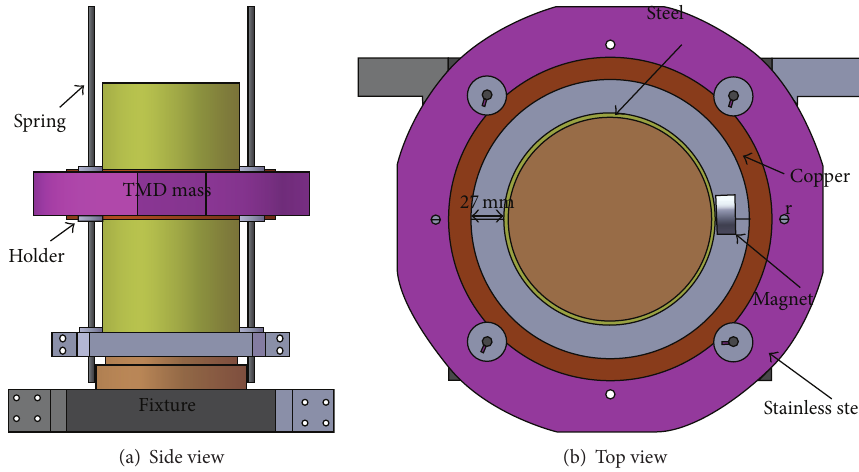
Figure 14: Schematic of mTMD.